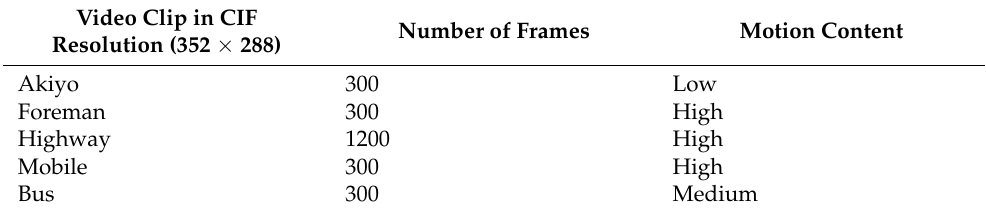
Table 2. Experiment